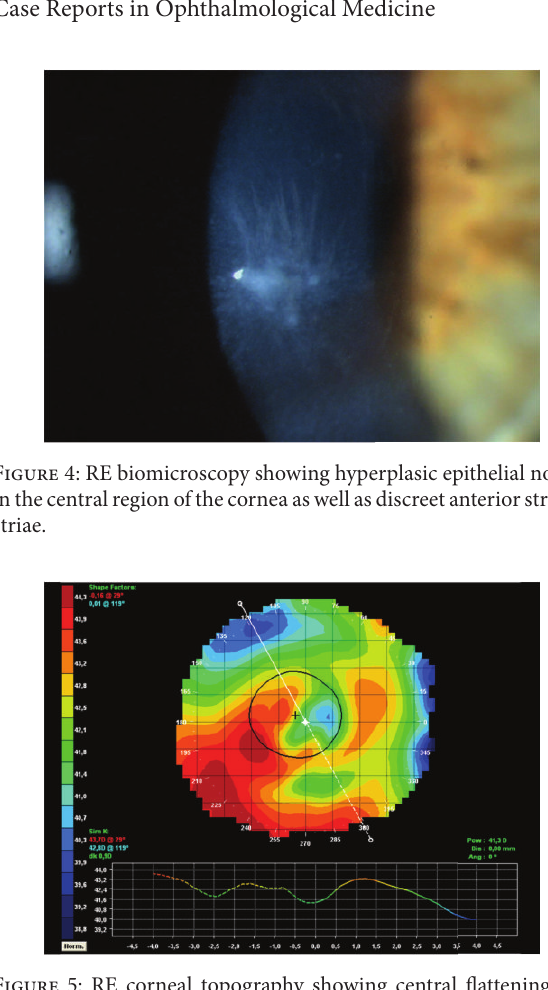
Figure 5: RE corneal topography showing central flattening and irregular astigmatism with stable ectasia after removal of nodule.